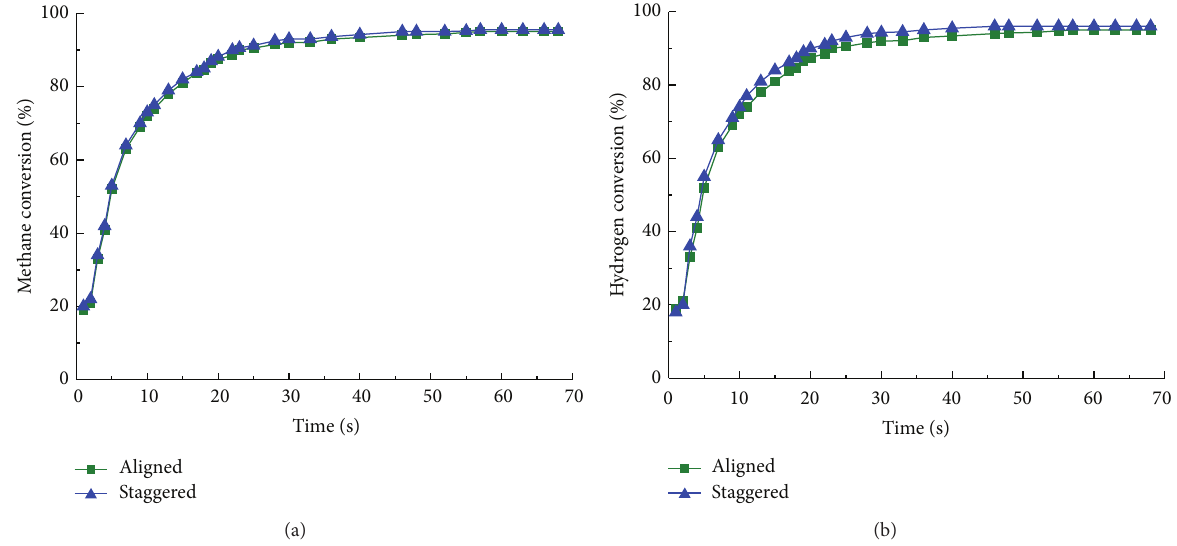
Figure 10: (a) Methane and (b) hydrogen conversion with aligned ( ◼ ) and staggered ( 󳵳 ) layout of cylinder for different reaction time.